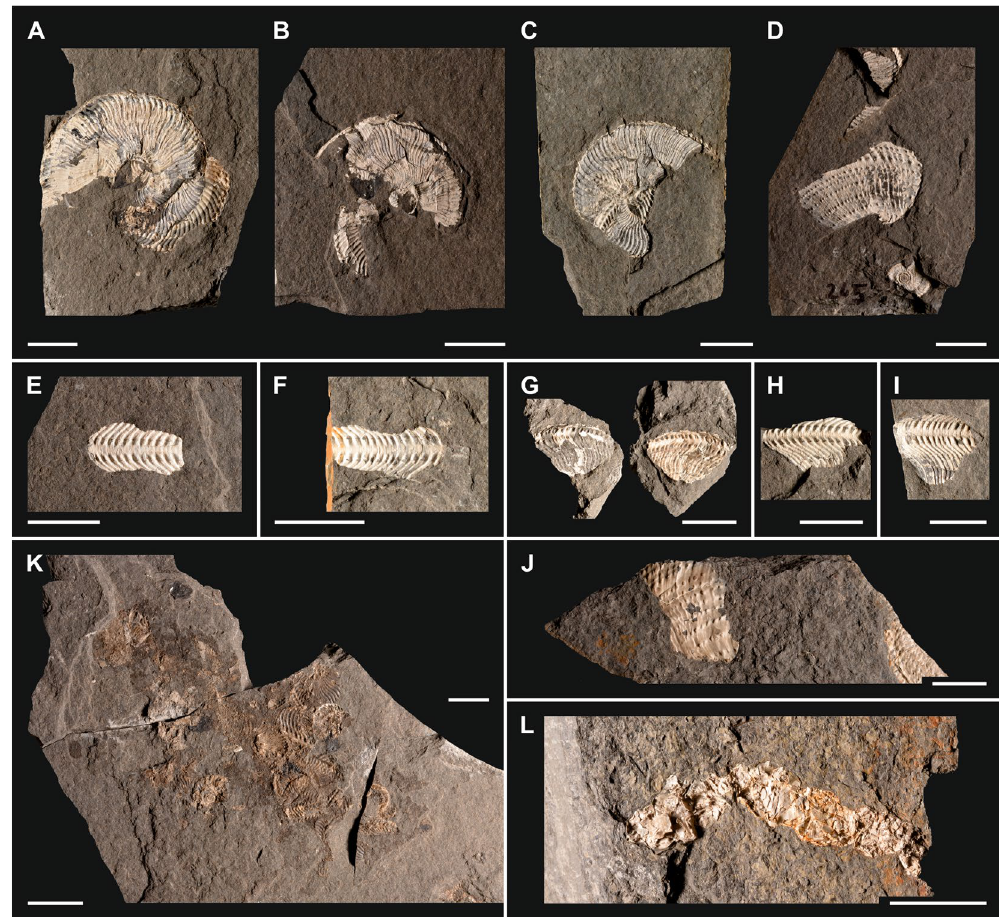
Figure 6. Ammonoid members with fatally bitten shells, fragments and bromalites of the Lower Carnian (Upper Triassic) Polzberg palaeobiota. ( A ) P. haberfellneri , positive, lateral view, adult specimens, fatally bitten ammonoid with dislocated shell fragments, NHMW 2021/0123/0153; ( B ) P. haberfellneri , positive, lateral view, adult specimens, fatally bitten ammonoid with dislocated shell fragments, NHMW 2021/0123/0154; ( C ) A. minor , fatally bitten ammonoid with dislocated shell fragments, NHMW 2021/0123/0155; ( D ) A. minor , lateral view, body chamber fragment, NHMW 2021/0123/0156; ( E ) A. minor , ventral view, ventrally oriented body chamber fragment, NHMW 2021/0123/0157; ( F ) A. minor , ventral view, ventrally oriented body chamber fragment, NHMW 2021/0123/0158; ( G ) A. minor , ventral view, ventrolaterally oriented body chamber fragment, NHMW 2021/0123/0159a, b; ( H ) A. minor , ventral view, ventrolaterally oriented body chamber fragment, NHMW 2021/0123/0160; ( I ) A. minor , ventral view, ventrolaterally oriented body chamber fragment, NHMW 2021/0123/0161; ( J ) A. minor , ventral view, ventrolaterally oriented body chamber fragment, NHMW 2021/0123/0162; ( K ) Bromalite mass with A. minor , P. haberfellneri and Anaptychus lunzensis, top view, entire and fragmented shells, NHMW 2021/0123/0163; ( L ) Bromalite chain, coprolite, consisting solely of ammonoid fragments, NHMW 2021/0123/0164. Scale bars: ( A – L ) 10 mm. Prepared by AL using CorelDRAW X7; www. corel draw.